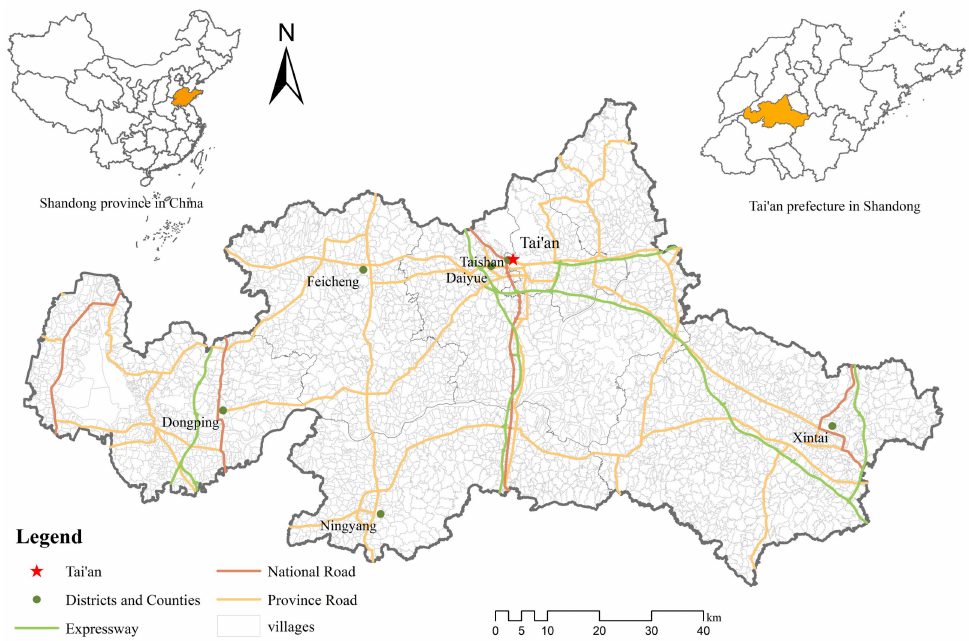
Figure 1. Overview of the study